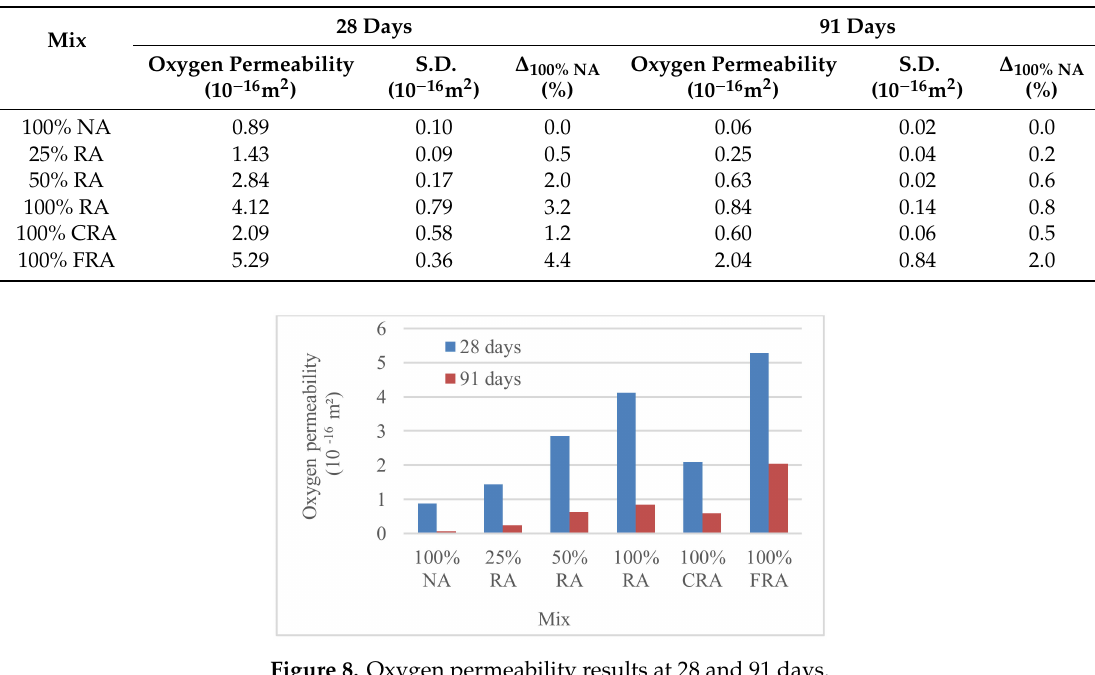
Table 7. Oxygen permeability results at 28 and 91 days.